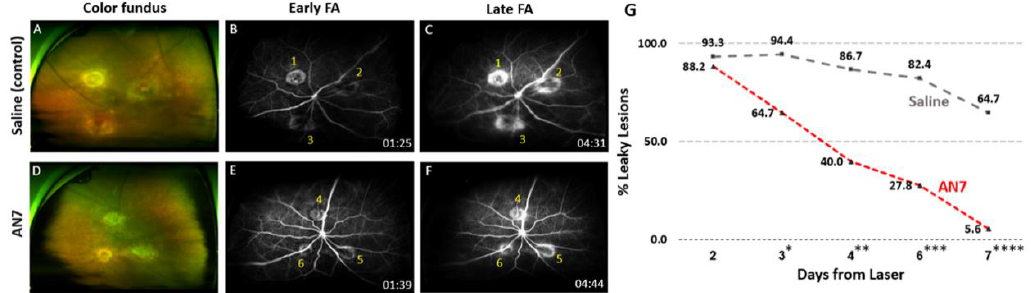
Figure 4. AN7 treatment reduces fluorescein leakage from laser lesions. Representative images of color fundus ( A , D ) and fluorescein angiography (FA; B , C , E , F ) from day 7 post CNV induction of mice treated by intraperitoneal (IP) 20 mg/kg AN7 or saline. Time of imaging post fluorescein injection is indicated at the bottom right side of each angiogram. ( B , C ) Early (1 to 2 minutes post fluorescein injection) and late (4 to 5 minutes post fluorescein injection) angiograms of an eye from IP saline-control group. Lesion one was classified as stained, while lesions two and three were classified as leaky. ( E , F ) Early and late angiograms of an eye from IP 20 mg/kg AN7-treated group. All three lesions were classified as stained. ( G ) The percentage of leaky lesions of total lesions (six mice with 18 lesions total for each group) on days 2 to 7 post CNV induction (the proportions of leaky and stained lesions in each group were tested using the Fisher’s exact test; *Day 3, p = 0.041; **Day 4, p = 0.021; ***Day 6, p = 0.002; ****Day 7, p = 0.0003).